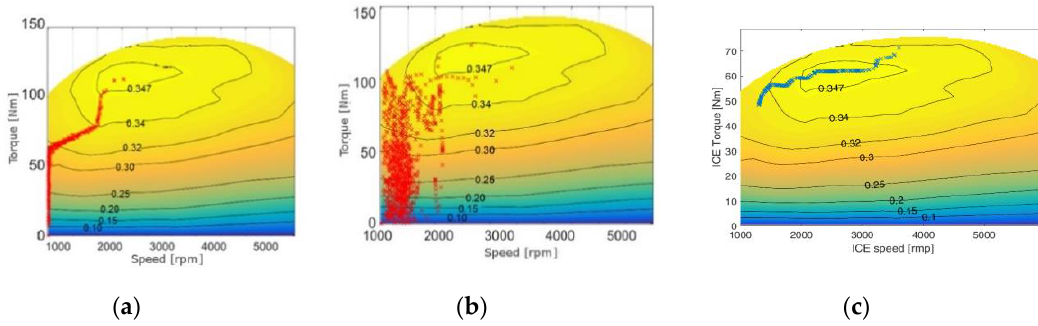
Figure 11. ICE work points in the parallel ( a ), series/parallel ( b ), and series ( c ) architecture [22].